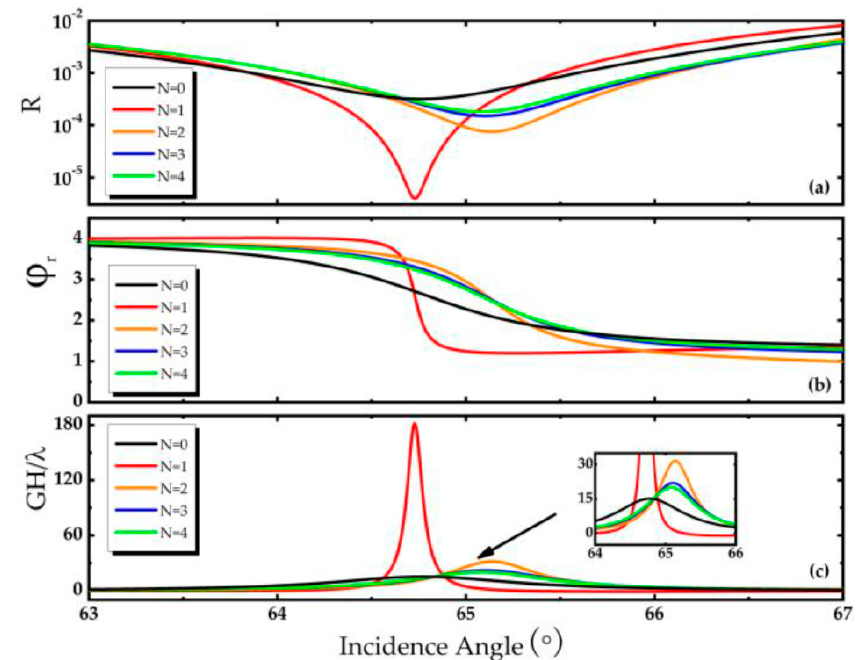
Figure 3. ( a ) Reflectance R as a function of incident angle at different layers of graphene, ( b ) Reflected phase ϕ r as a function of incident angle at different layers of graphene, ( c ) GH shift as a function of incident angle at different layers of graphene, in which Fermi energy E F = 0.2 eV, Ag thickness d 2 = 15 nm, Au thickness d 3 = 20 nm, hBN thickness d 4 = 131